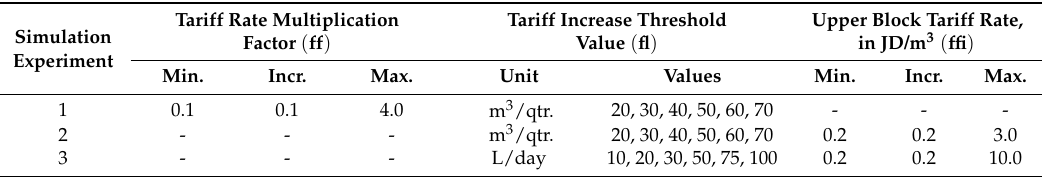
Table 5. Parameter values in the simulation of IBT